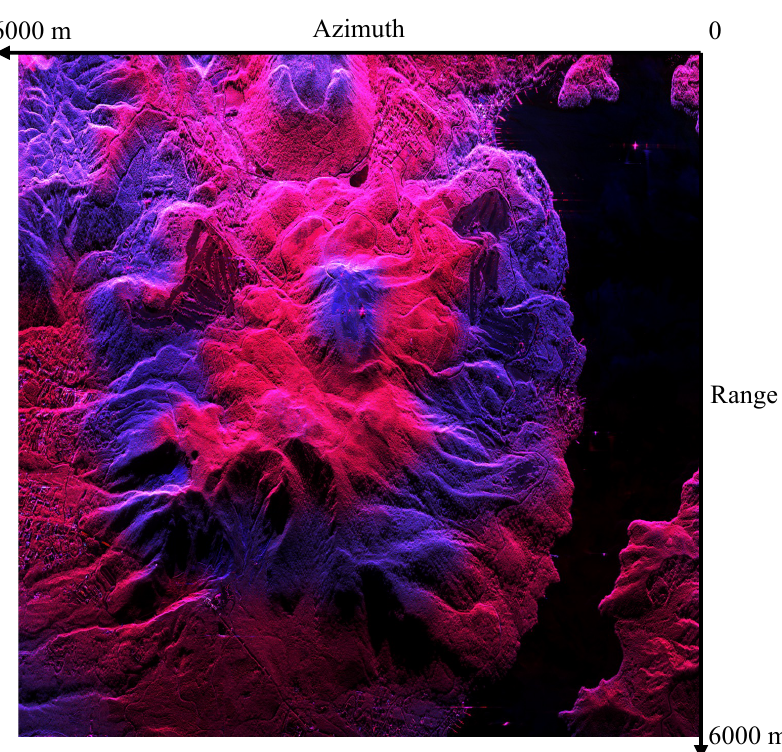
Figure 11. 6SD image before calibration around Mount Hakone on 3 December 2015. (Center: N35.218, E139.031).